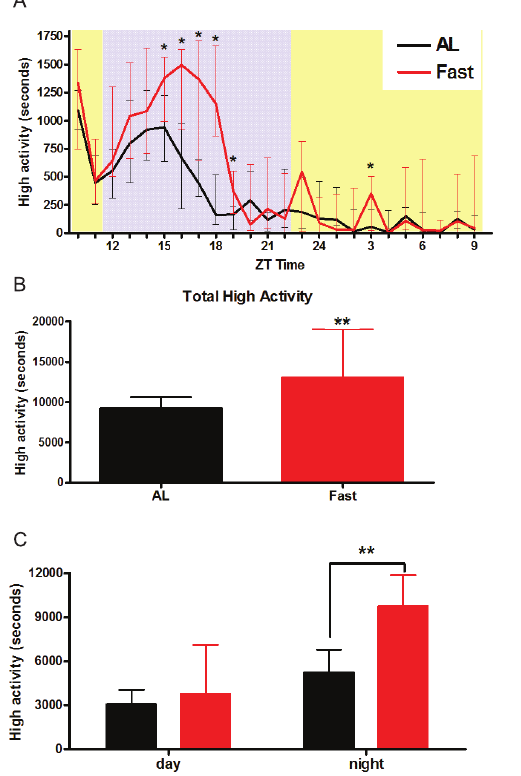
Figure 1. High activity profiles, and total diurnal and nocturnal activity of ad libitum and acutely fasted mice. (A) The seconds of high activity per hour in a 24 hour video recording of AL mice (black) or acutely fasted mice (red). The light phase is shown in yellow (ZT 10–12) followed by 11 hours of darkness indicated in gray (ZT 12–23) followed by light (ZT 24–9) (B) The total high activity summed across the 24 hour recording for AL and fasted mice. (C) The total high activity during the light and dark periods. n=13 fasted and n=15 AL. Values represent medians + / 2 IQ range. The statistical significance was tested using Mann-Whitney test; **denotes p ,